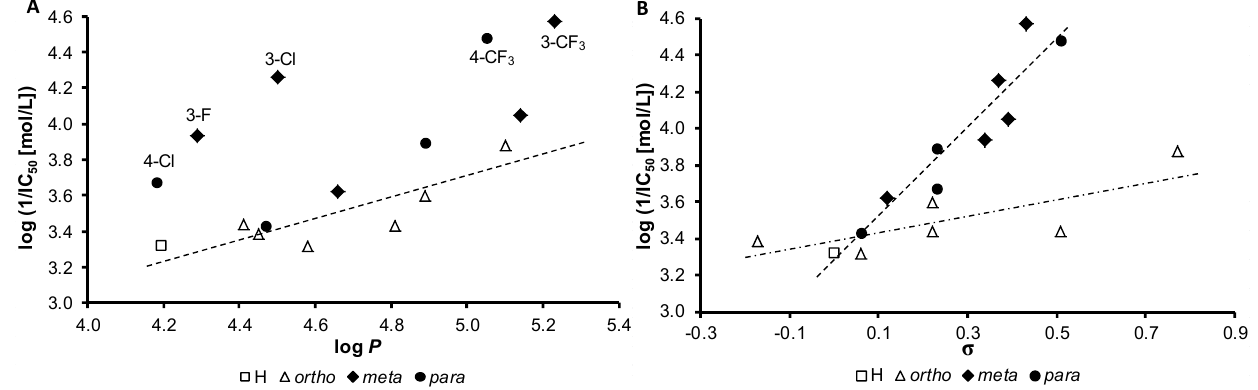
Figure 1. Relationships between PET inhibition log(1/IC chloroplasts and lipophilicity expressed as log P (Figure 1A) or N -substituent electronic Hammett’s σ parameters (Figure 1B) of selected studied